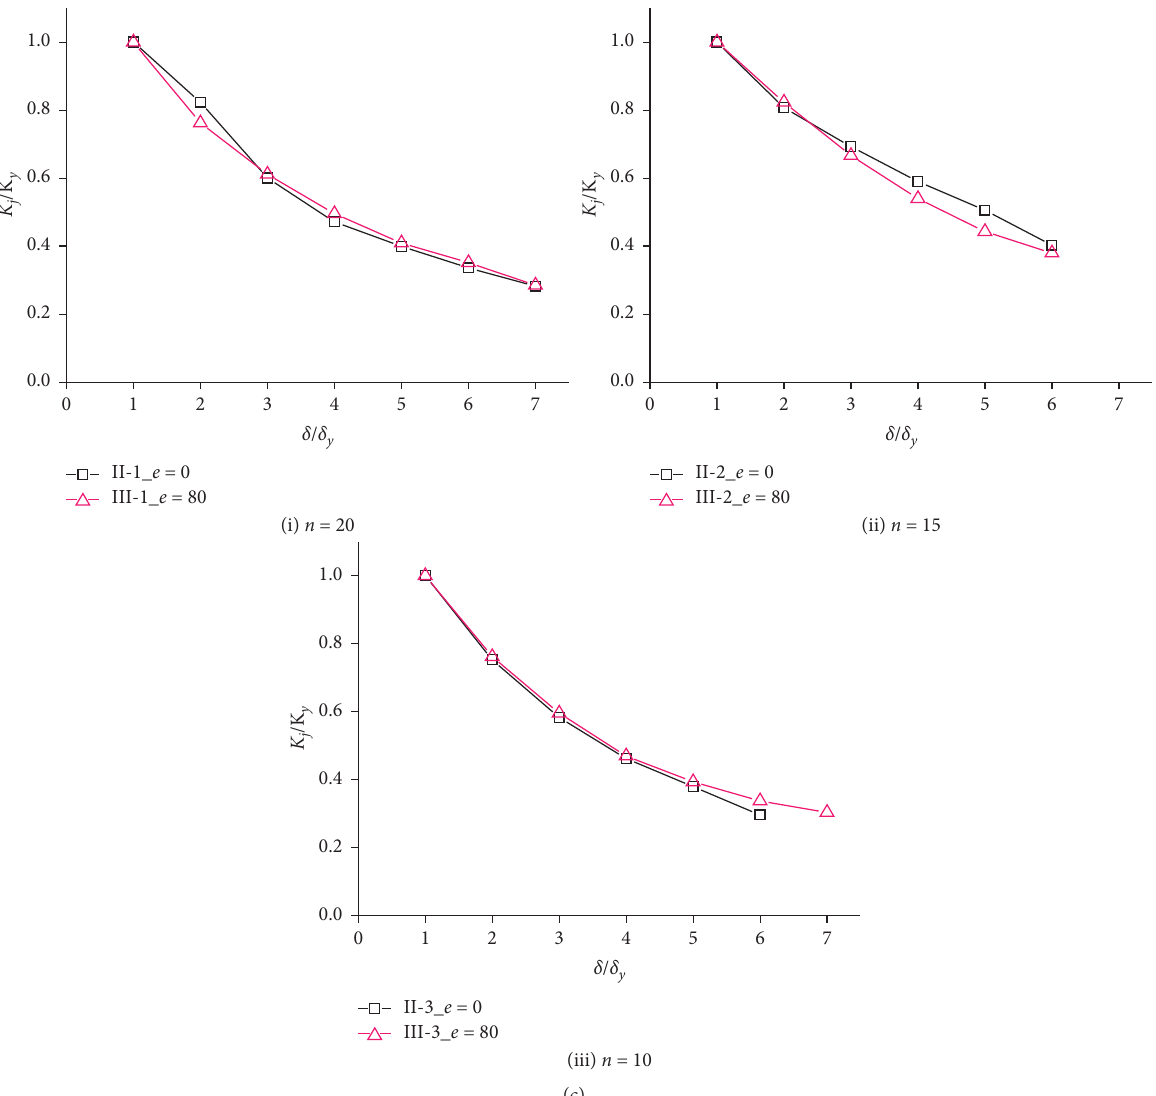
Figure 10: Degradation characteristic of stiffness. (a) Effects of installing buckling-restrained energy dissipation wall plates. (b) Effects of axial compression ratio n . (c) Effects of eccentricity e